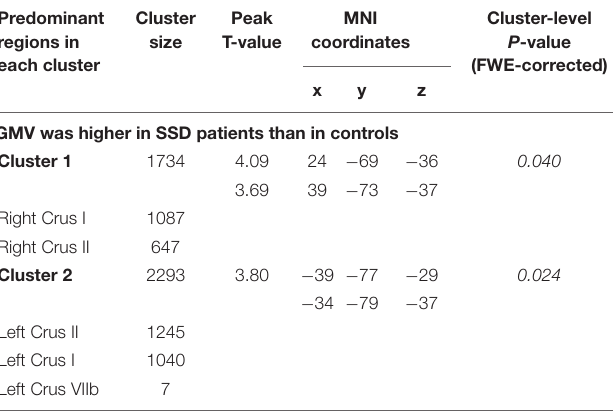
TABLE 2 | Significant inter-group differences in suitVBM analysis.